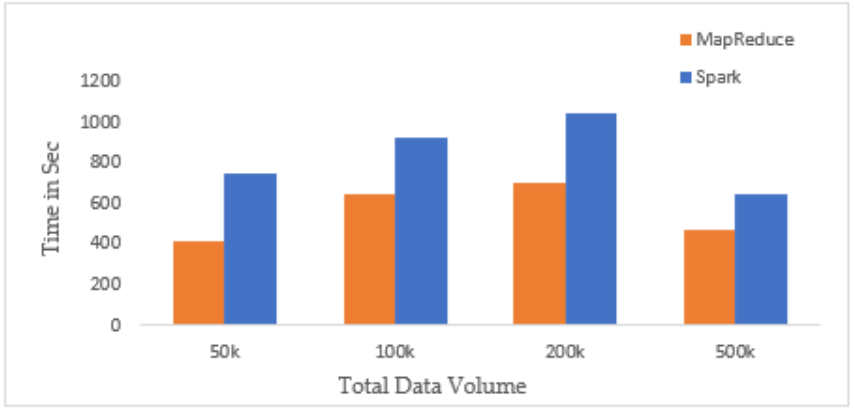
Figure 5. Effect of new metrics in skyline computation.